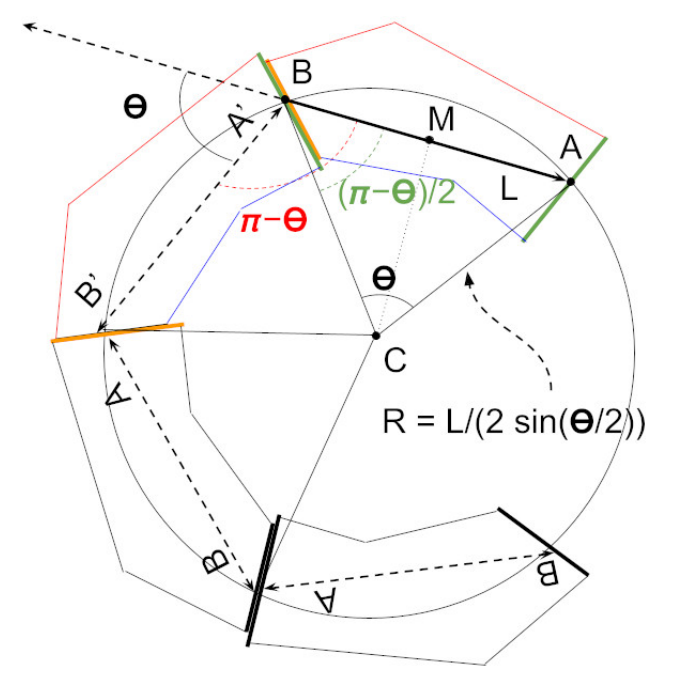
Figure 2. A 2D analog of a helix generated by repeated